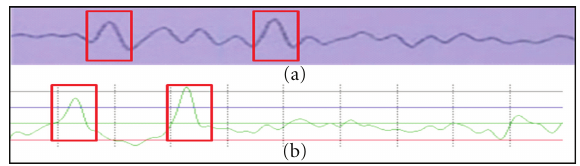
Figure 13: P300 visual evoked potential